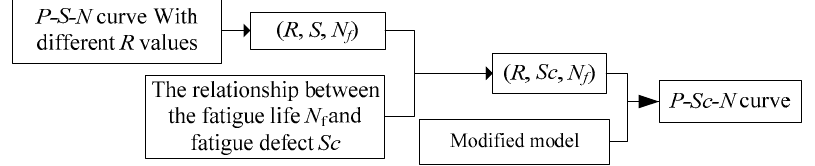
Figure 11. The logical relationship between fatigue reliability, fatigue crack and fatigue life.